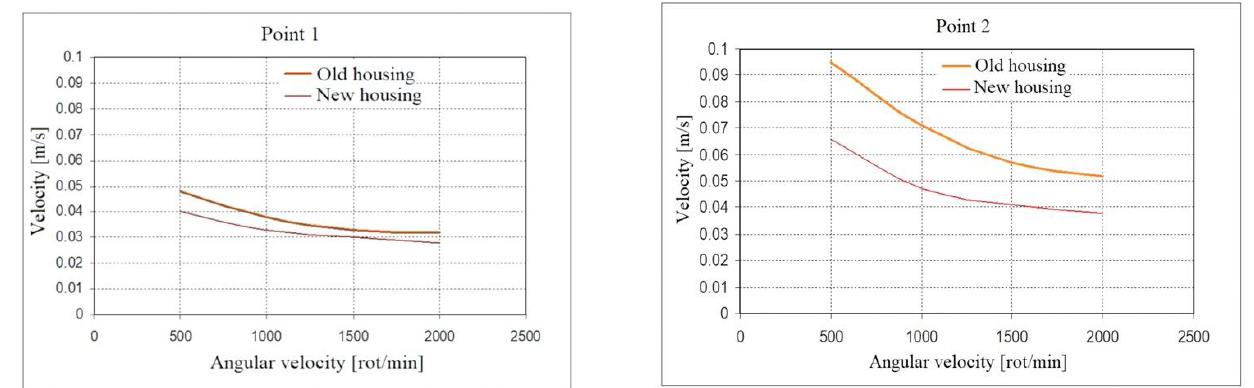
Figure 23. Measured accelerations at points 5 and 6 for the two versions (old and new).